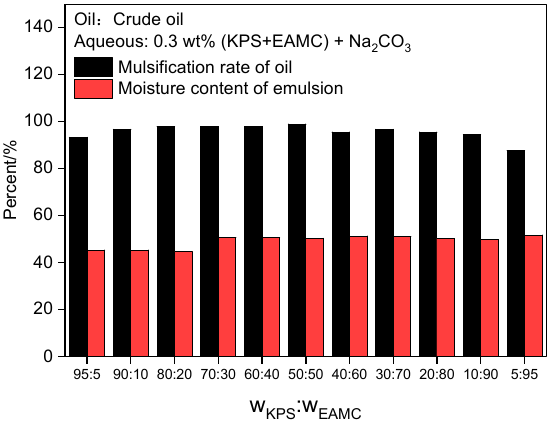
Figure 9. The effect of a mixed surfactant ratio on the emulsification properties.